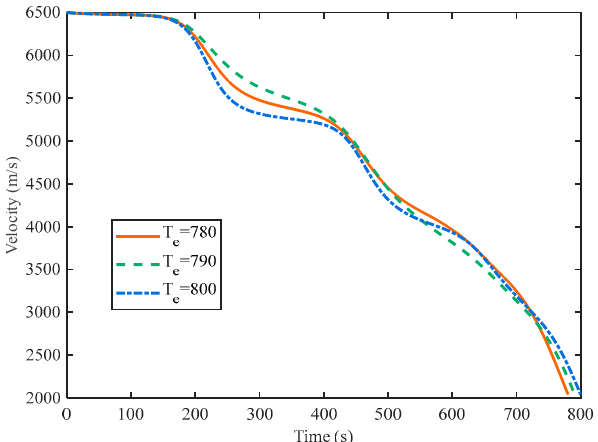
Figure 4. Time histories of the velocity.